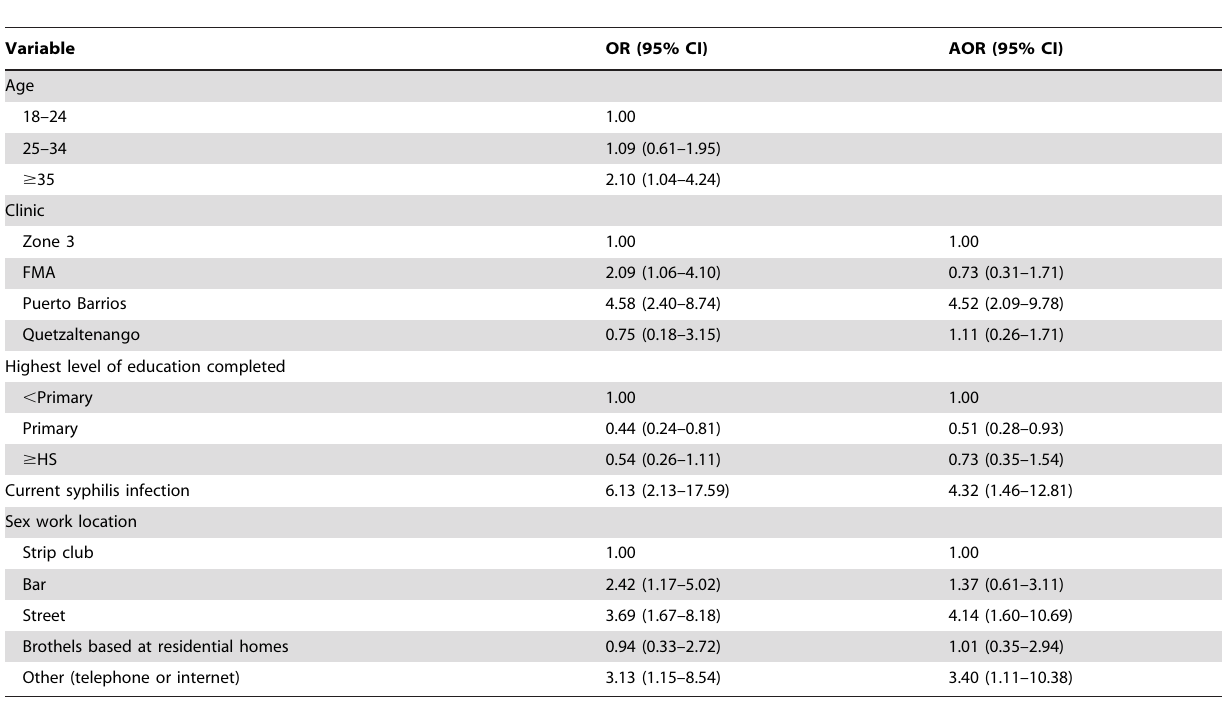
Table 3. Risk factors associated with HIV infection among FSW attending VICITS clinics for the first time, Guatemala, 2007–2011 (N=